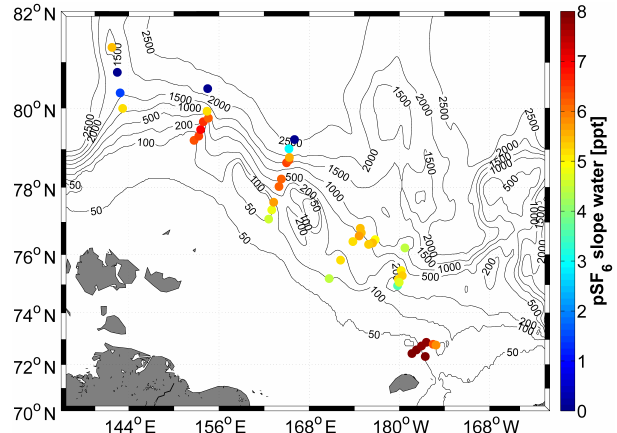
Figure 6. SF 6 partial pressure (ppt) in the sample collected closest to the bottom, typically 5–10m